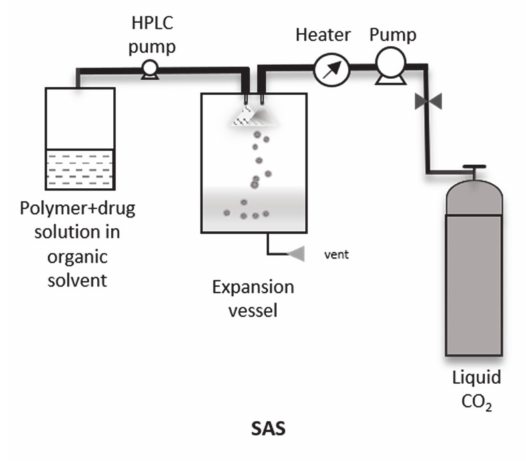
Figure 4. Schematic representation of SAS process.